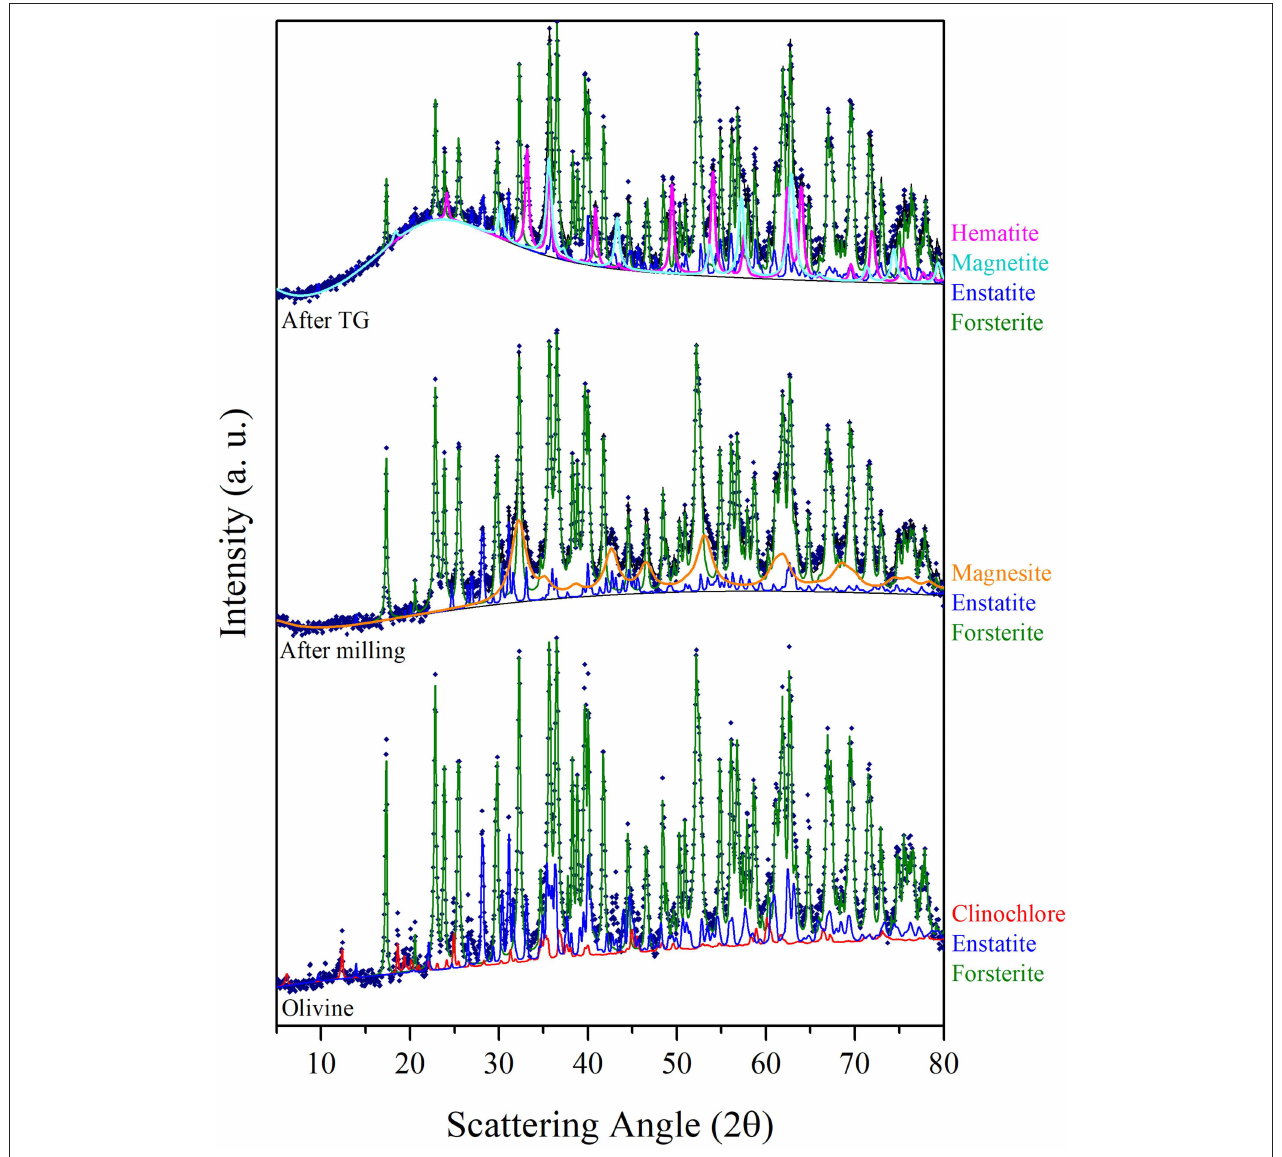
FIGURE 4 | The CuK α XRD patterns sequence displays, from the bottom, the analyses of the Olivine in the as received state, the one of the sample at the end of 90min of mechanical activation in the first series of runs, and the one further subjected to the thermogravimetric analysis. Experimental points are fitted by the Rietveld refinement